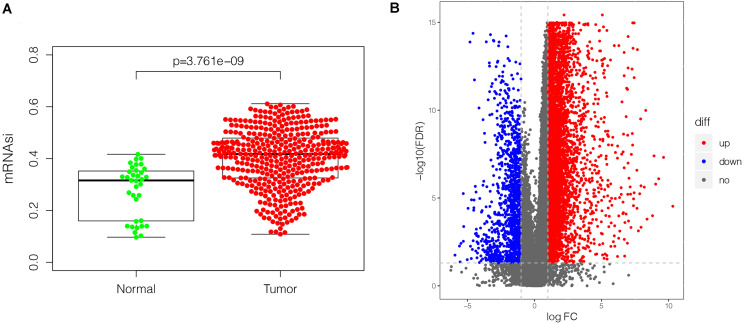
The mRNAsi and DEGs in GC (375 tumor tissues and 32 non-tumor tissues) based on TCGA database. (A) Differences in mRNAsi in GC tissues vs. non-tumor tissues. (B) volcano plot showing differential expression in GC tissues vs. non-tumor tissues. The upregulated gene is displayed in red dot and the downregulated gene is in blue. In total, 6,739 DEGs were identified, of which 5,593 were upregulated, and 1,146 were downregulated. mRNAsi, mRNA expression-based stemness index; DEGs, differentially expressed genes; GC, gastric cancer; TCGA, The Cancer Genome Atlas.